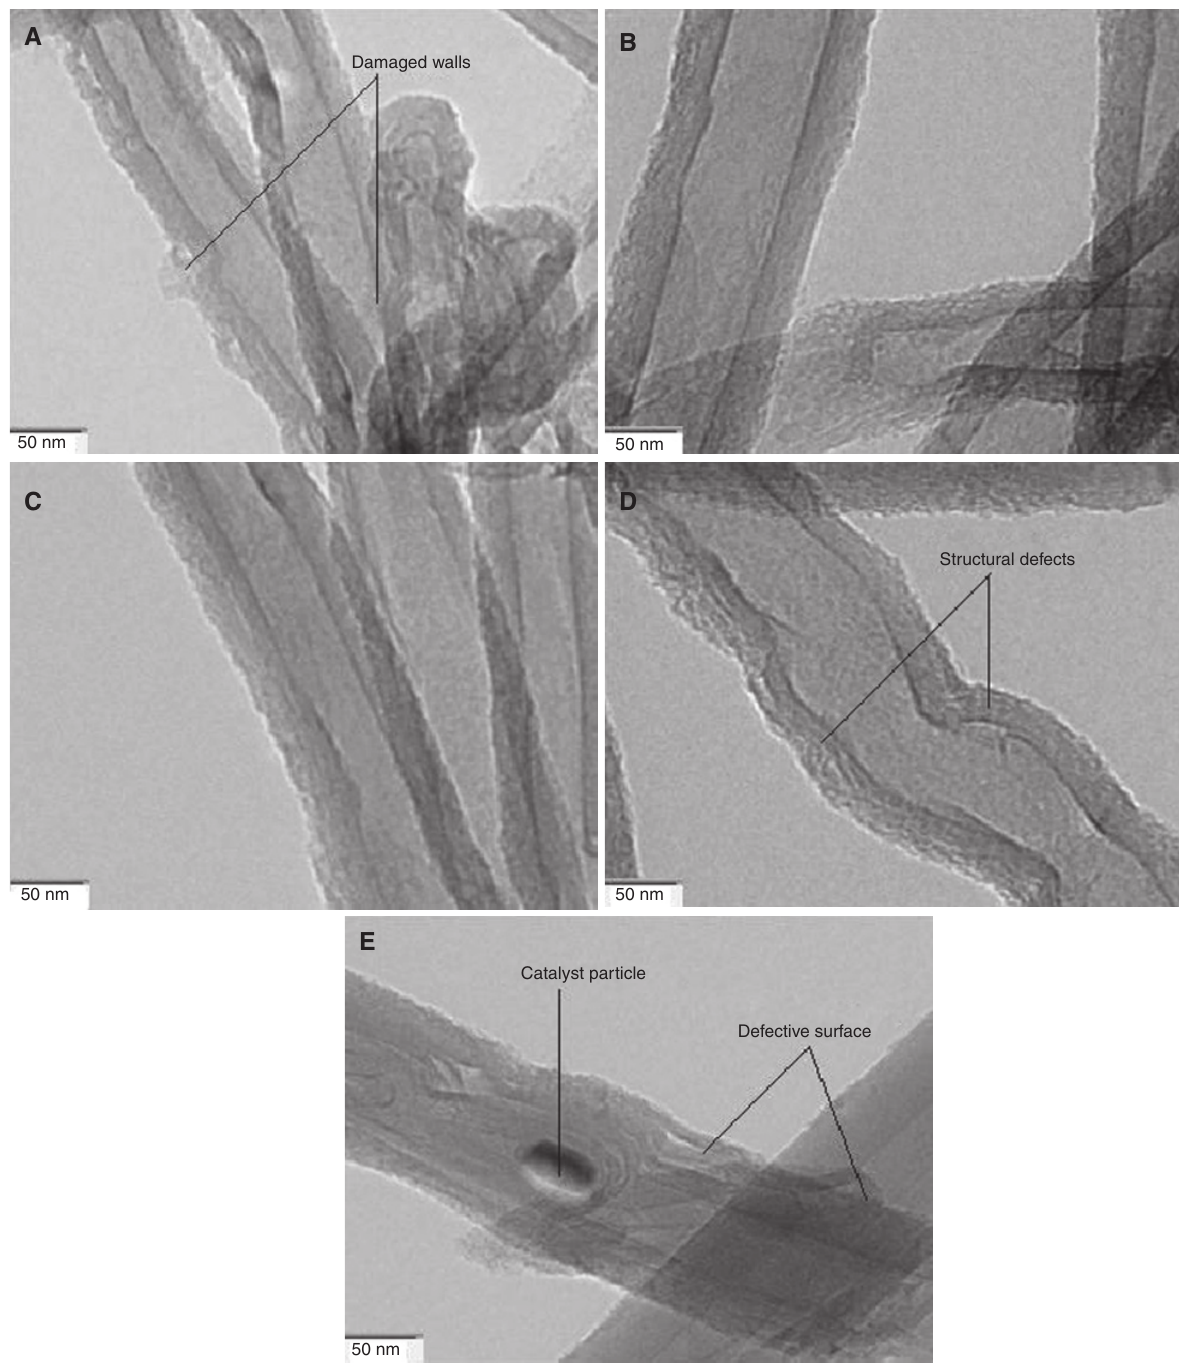
Figure 3: TEM micrographs of MWCNTs grown with different weights of ferrocene. (A) 0.1 g ferrocene, (B) 0.125 g ferrocene, (C) 0.15 g ferrocene, (D) 0.175 g ferrocene, (E) 0.2 g